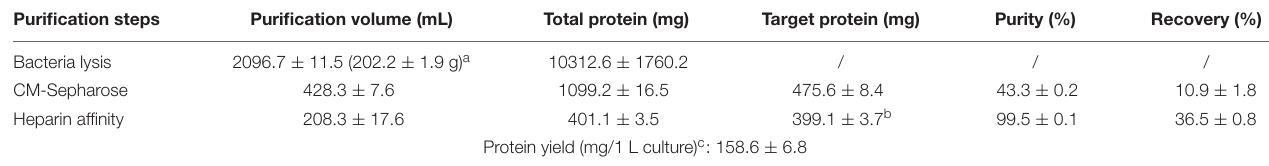
TABLE 3 | Summary of the purification steps of rhaFGF 135 ( n =